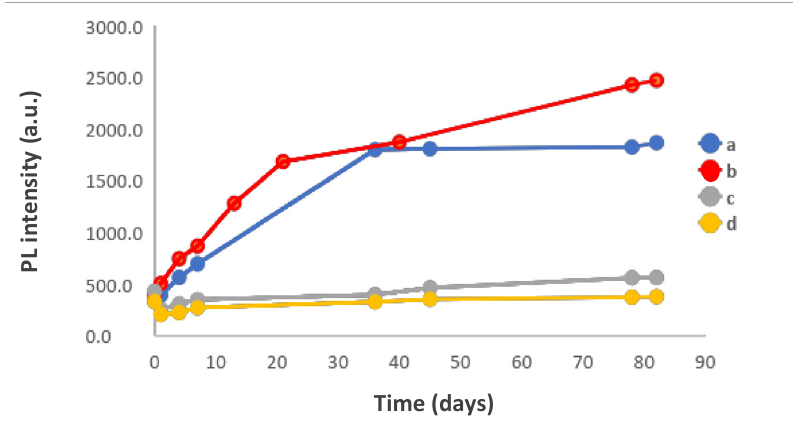
Figure 5. Influence of [Cd 2+ ] F /[thioacetamide] F at 4 °C. Temporal evolution of Photoluminescence intensity of CdS QDs solutions with different [Cd 2+ ] F /[thioacetamide] F ratios; ( a ) 4.0, ( b ) 2.0, ( c ) 0.8, ( d ) 0.4.